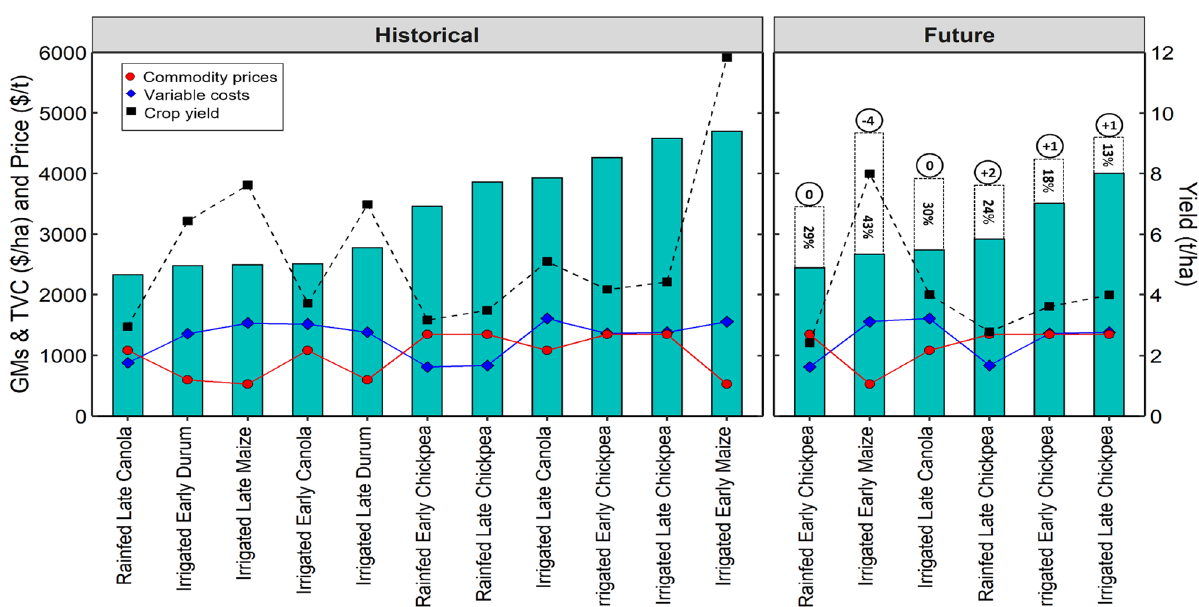
Figure 6. Gross margins as a function of grain prices, yield and variable costs for a hot dry region (Kerang) under historical and future climates. Green bars represent gross margins (GMs) for the most profitable farm systems. Black dotted line represents peak grain yield at optimal flowering time. The red line represents long- term high grain prices, while the blue line represents the highest total variable costs (TVC). Dotted bar segments represent percentage reduction in GMs and numbers in black circles represent change in crop rank relative to historical climates (positive and negative denote shift to the right and left,